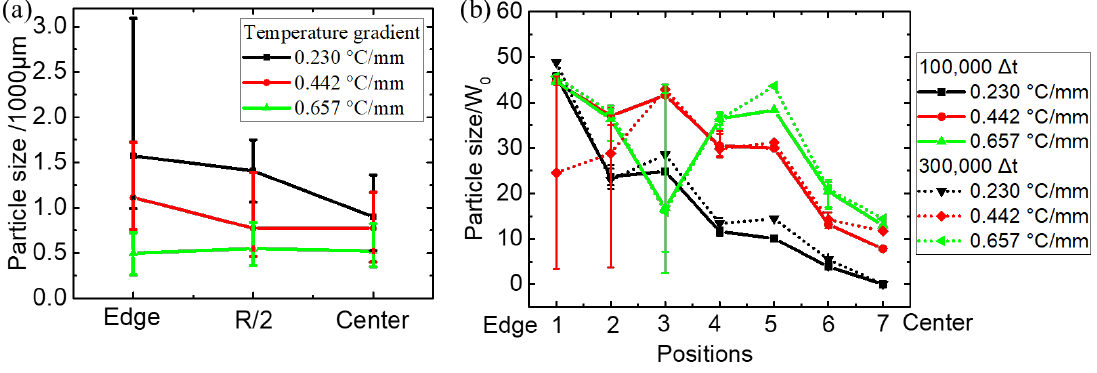
Figure 11. Statistical results about grain size of ( a ) experiment and ( b ) simulation.